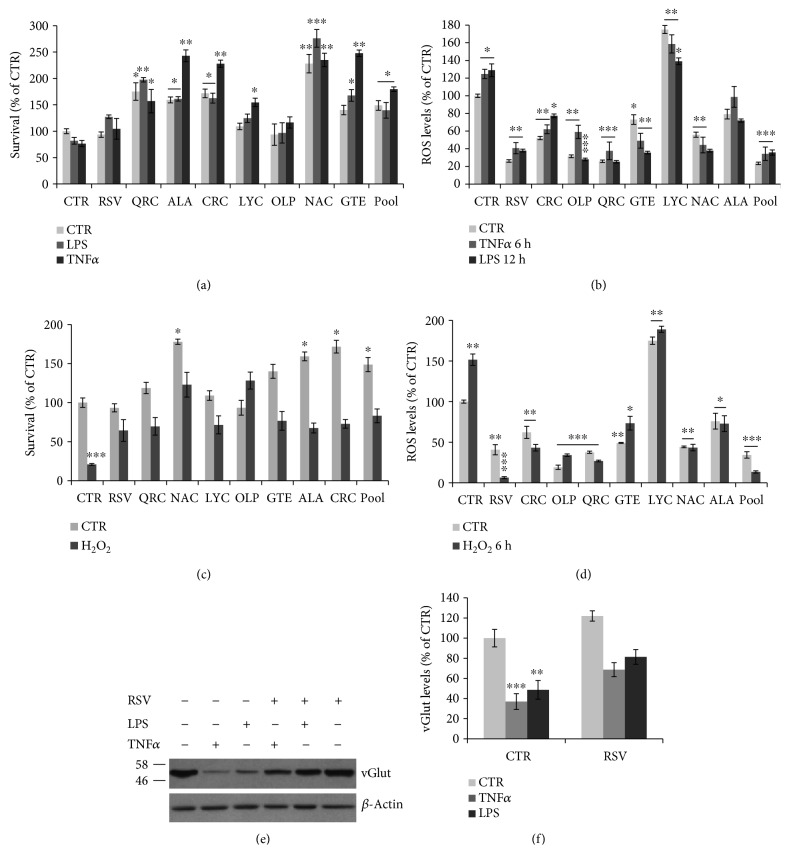
Effect of antioxidants on ROS levels and astrocyte viability. (a) Survival by the MTT assay of cortical astrocytes stimulated with TNFα (10 ng/ml) or LPS (1 μg/ml) for 24 h and the effect of RSV (10 μM), QRC (10 μM), ALA (10 μM), CRC (10 μM), LYC (10 μM), OLP (100 μg/ml), GTE (12.5 μg/ml), NAC (300 μM), or pool. (b) Quantitation of astrocytic ROS levels by FACS analysis of DCH2F-DA fluorescence following stimulation with TNFα (10 ng/ml) for 6 h, or LPS (1 μg/ml) for 12 h, and effect of the indicated antioxidants and pool. (c) MTT assay on astrocytes exposed to H2O2 (200 μM) for 24 h in the presence or absence of the indicated antioxidants and pool. (d) ROS levels in astrocytes treated with H2O2 (200 μM) for 6 h in the presence or absence of the indicated antioxidants and pool. All data are expressed as percent of CTR. MTT data are the mean ± SEM of three independent experiments, each performed with 4-6 samples for each treatment. ROS data are the mean ± SEM of three independent experiments, each performed in duplicate. (e, f) Western blot analysis and quantitation of vGLUT levels in astrocytes treated for 24 h with TNFα (10 ng/ml) or LPS (1 μg/ml) and the effect of RSV cotreatment. Data, expressed as percent of CTR, are the mean ± SEM of three independent experiments. ∗p ≤ 0.05, ∗∗p ≤ 0.01, and ∗∗∗p ≤ 0.001 versus CTR (ANOVA and Dunnett's multiple comparison test).